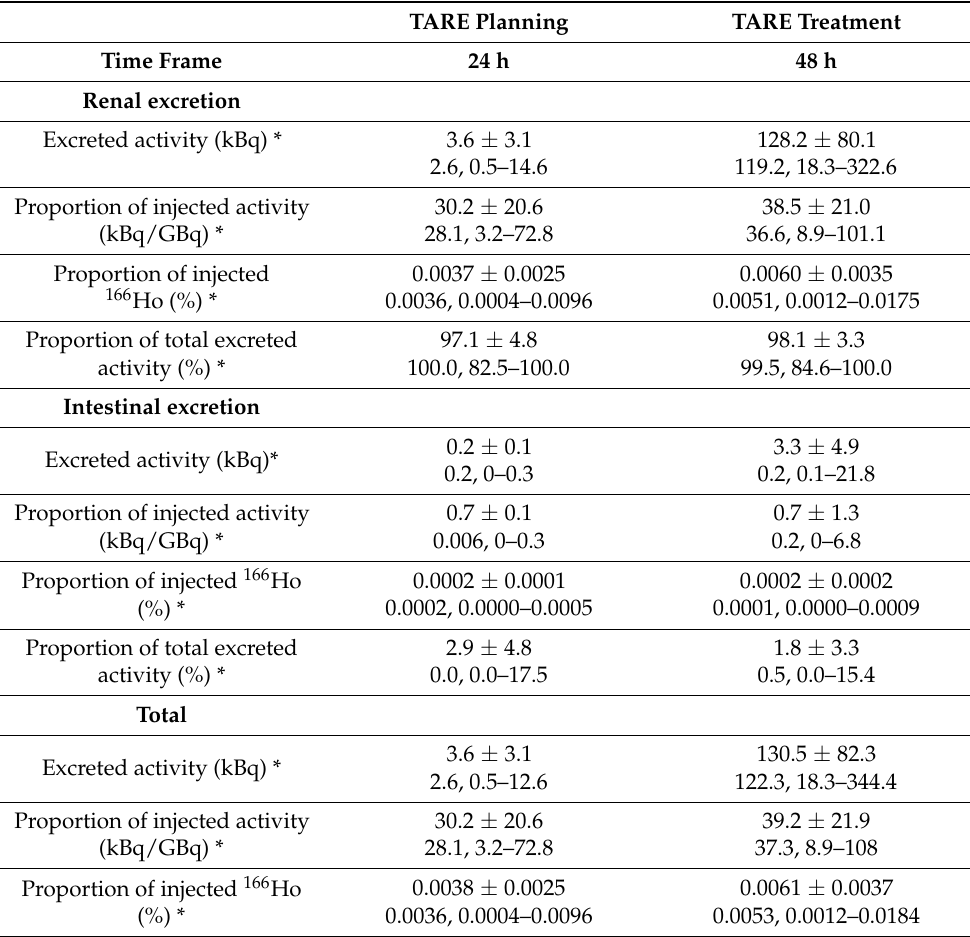
Table 4. Total activity excretion.